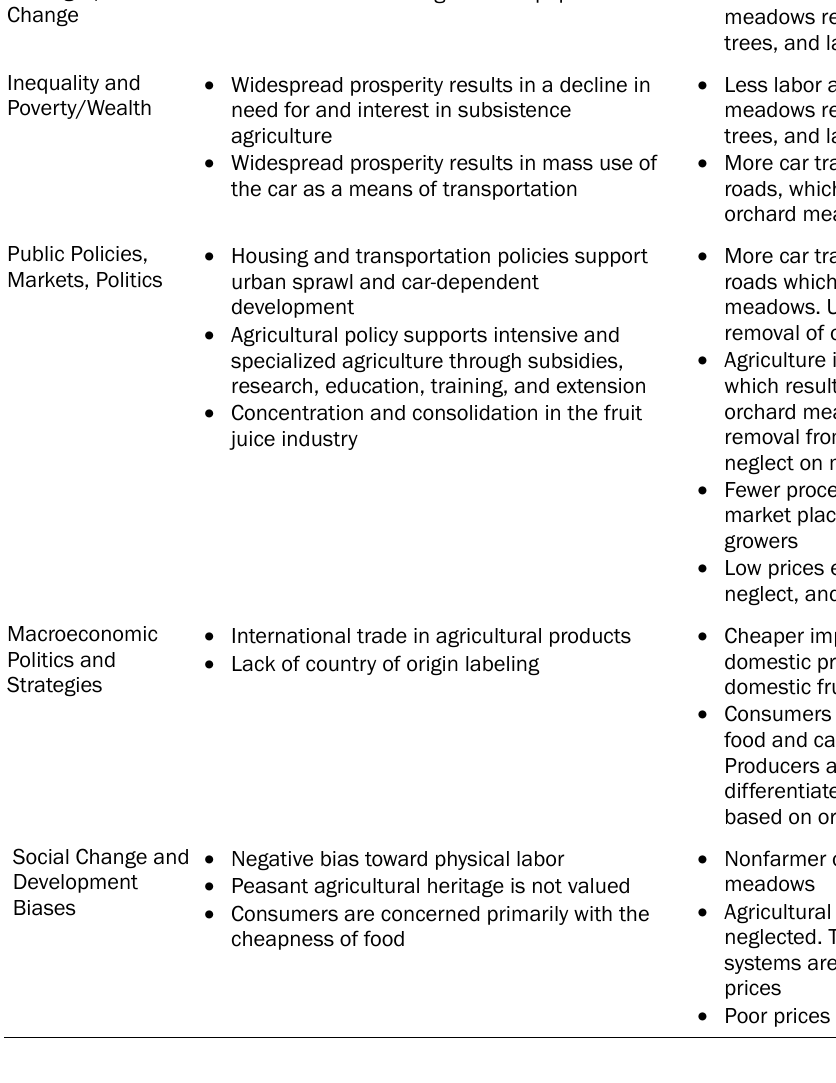
Table 3. The Decline of Orchard Meadows as Described by the Key Informants, Classified According to the Five Categories of Socio-economic Drivers Described by Stedman-Edwards (2000) Type of